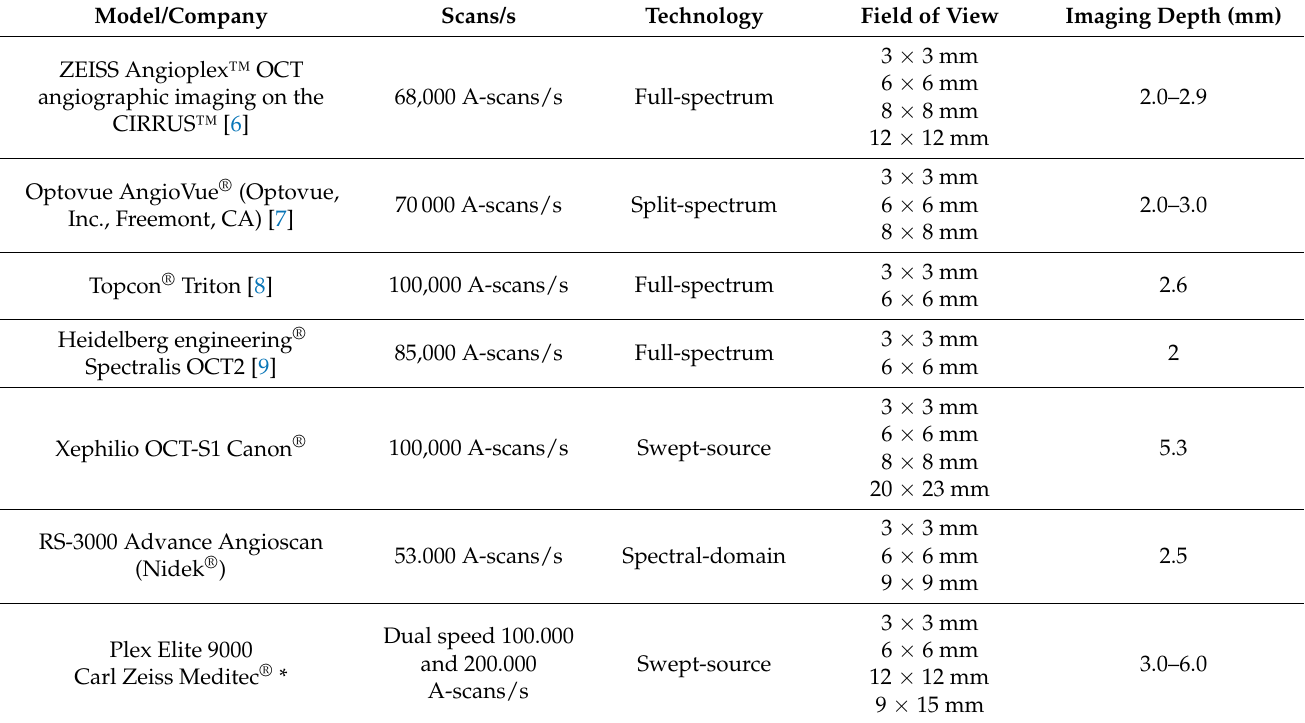
Table 1. Available OCT-A instruments on the